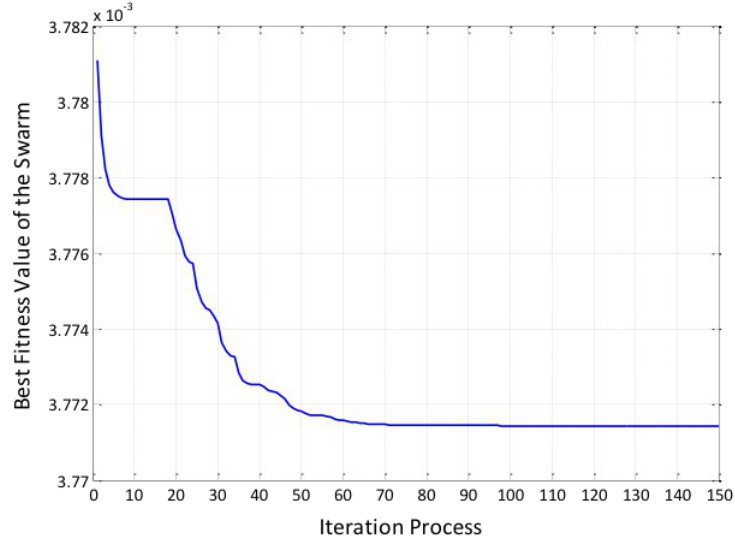
Figure 5. Fitness value of the best particle in every